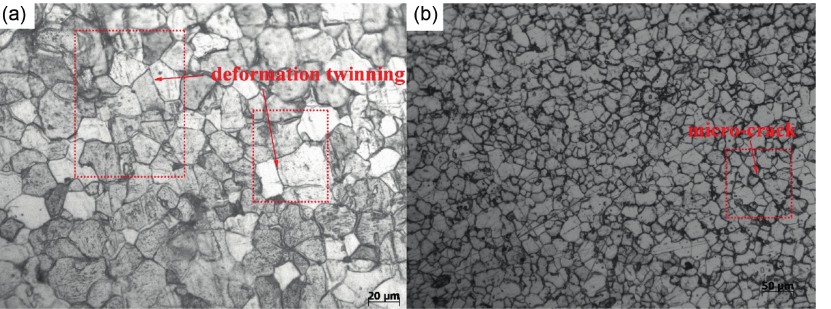
Figure 11: Optical microstructure of ultra-high strength steel BR1500HS at (tensile axis is vertical): (a) strain rate of 1 s – 1 , temperature of 773K; (b) strain rate of 1 s – 1 , temperature of